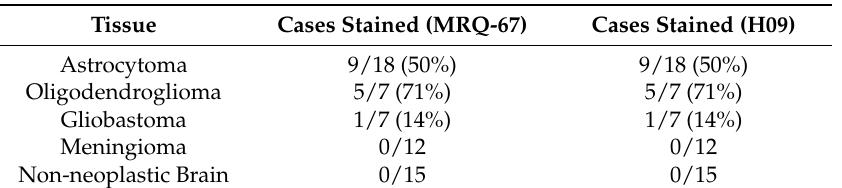
Table 1. IDH1 R132H immunohistochemistry (IHC) staining data. Summary of IHC staining results comparing the number of cases stained positive out of the total number of cases tested with the MRQ-67 and H09 clones.